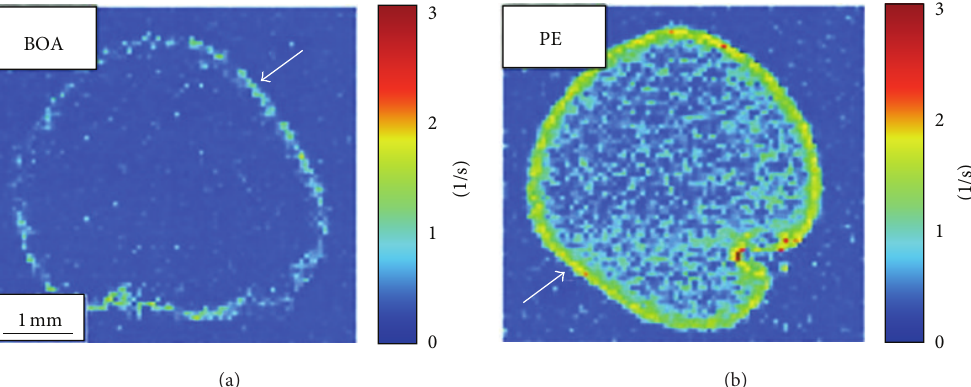
Figure 1: MRI of human plasma clots treated with fibrin targeted perfluorocarbon nanoparticles formulated with either Gd-DTPA-BOA (a) or Gd-DTPA-PE (b) as the imaging contrast agent. The Gd-DTPA-BOA nanoparticles increased the R1 value at the clot surface by 48%, while the Gd-DTPA-PE particles increased the R1 by 72%. The improved relaxation effect was not a result of increased binding of the Gd- DTPA-PE particles to the clot surface, since both agents produced identical gadolinium levels on the clot samples: 0.22 ± 0.01 𝜇 mol Gd 3+ for Gd-DTPA-BOA particles and 0.22 ± 0.02 𝜇 mol Gd 3+ for Gd-DTPA-PE particles. Reprinted with permission from [39].